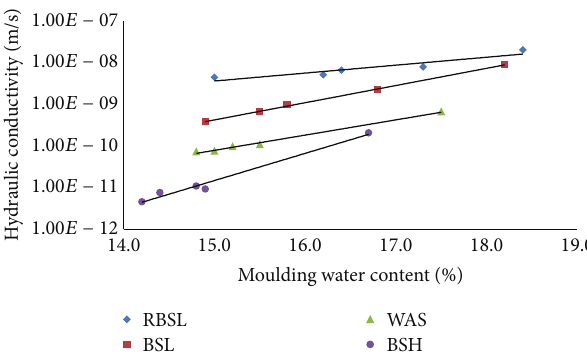
Figure 5: Hydraulic conductivity versus moulding water content for soil permeated with